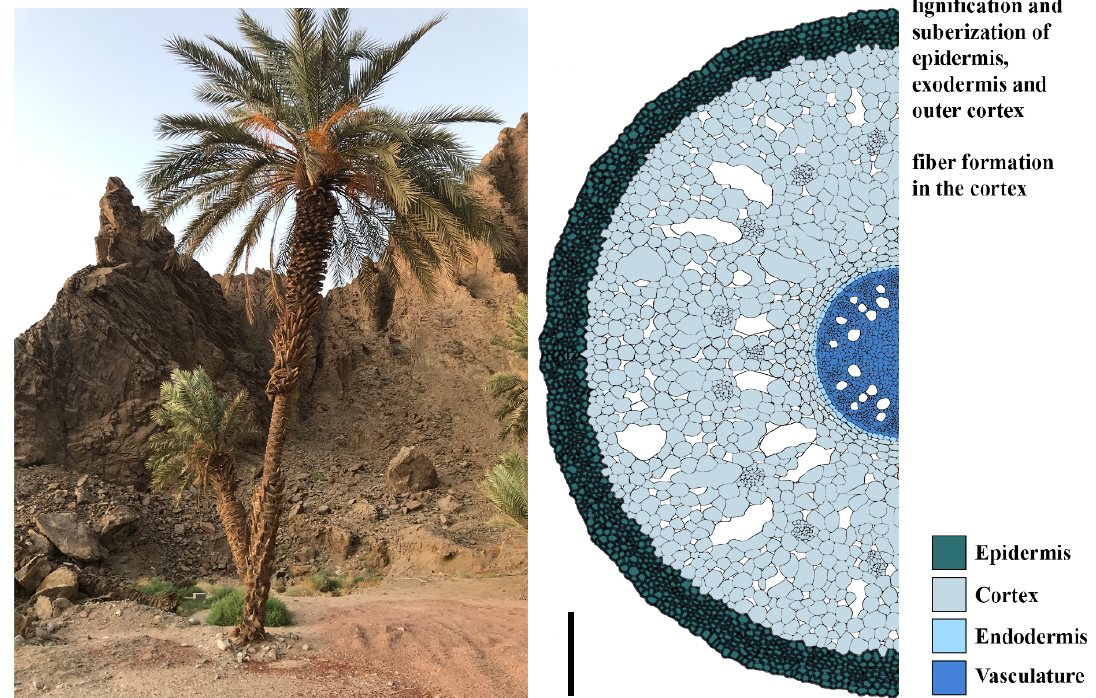
Figure 5. Left:date palm growing at the red sea shore in Tabuk region, Saudi Arabia. Right: schematic representation of a date palm root (cross-section); scale bar 200 μm.